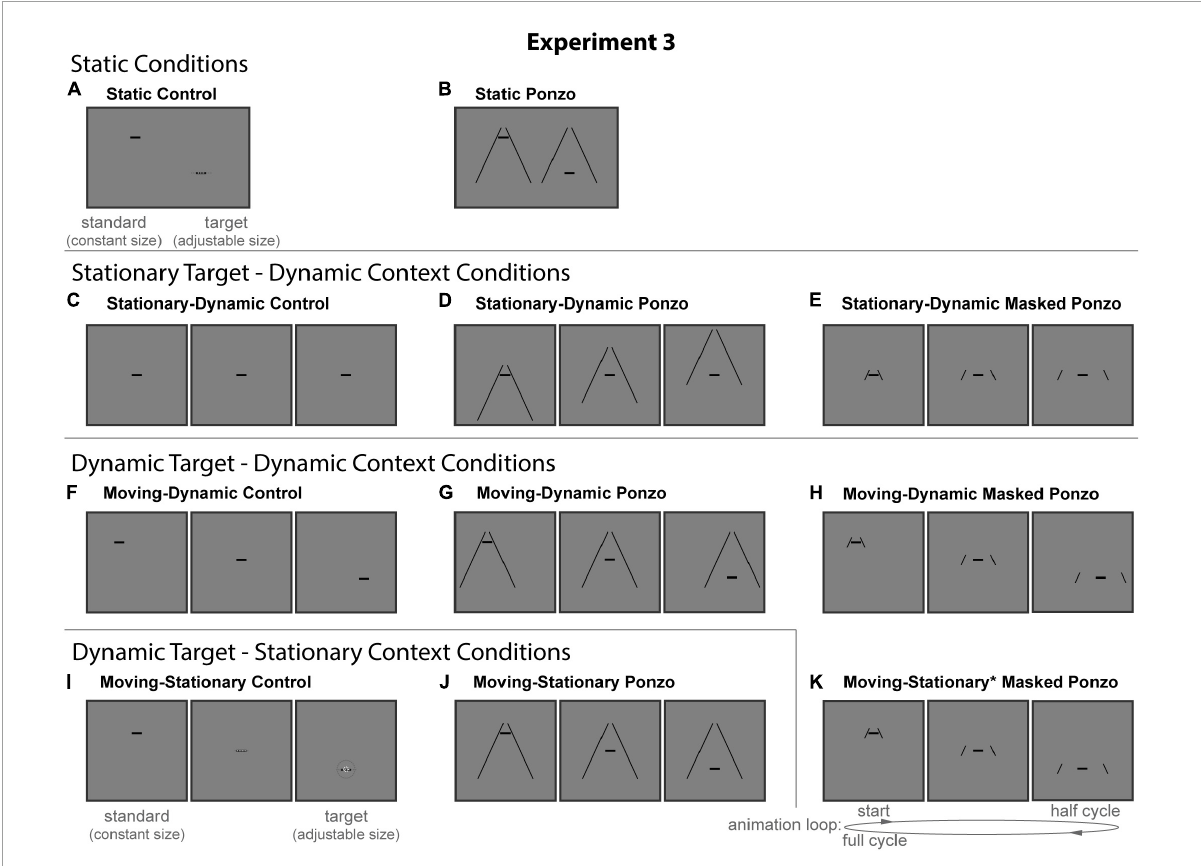
FIGURE6 The 11 conditions of Experiment 3. Columns represent the three distinct contexts [Control (A,C,F,I) , Ponzo (B,D,G,J) , Masked Ponzo (E,H,K) ]. Rows represent the four configurations [Static (A,B) , Stationary-Dynamic (C–E) , Moving-Dynamic (F–H) , and Moving-Stationary (I–K) ]. For each condition, screenshots for the beginning (standard line), middle, and end (target line) frames are shown. The animation [as labeled in panel (K) ] played in a continuous loop. In the figure, the central line is the same physical size in all frames; during the experiment, the target (lower right line for Static conditions or the far-right frame for Dynamic conditions) was adjusted by the participant [see panels (A,I) ]. Here, stimuli are cropped to display the central portion of the screen to save space. Supplementary Video 3 showing all of the dynamic conditions for Experiment 3 can be found in the Supplementary materials (best viewed in “loop”